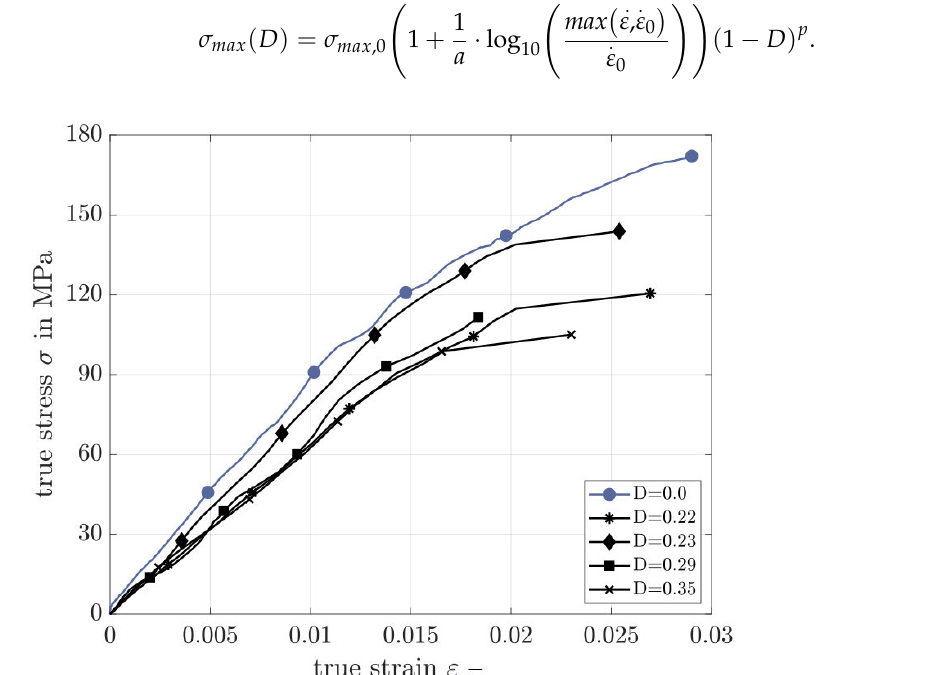
9 of 12 Figure 8. Comparison of the stress–strain curve with various damaged specimens in 0° orientation.